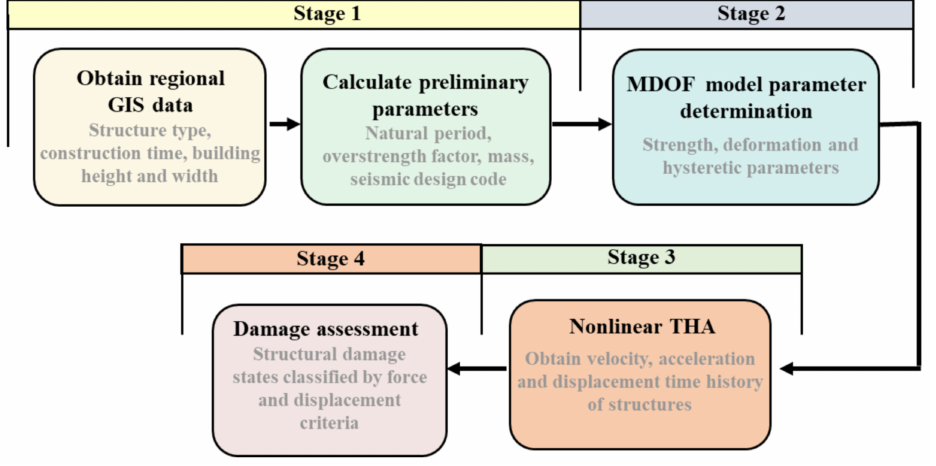
Figure 2. Flowchart of the MCS model analysis. Table 3. Comparison of the parameter determination procedures of several MCS